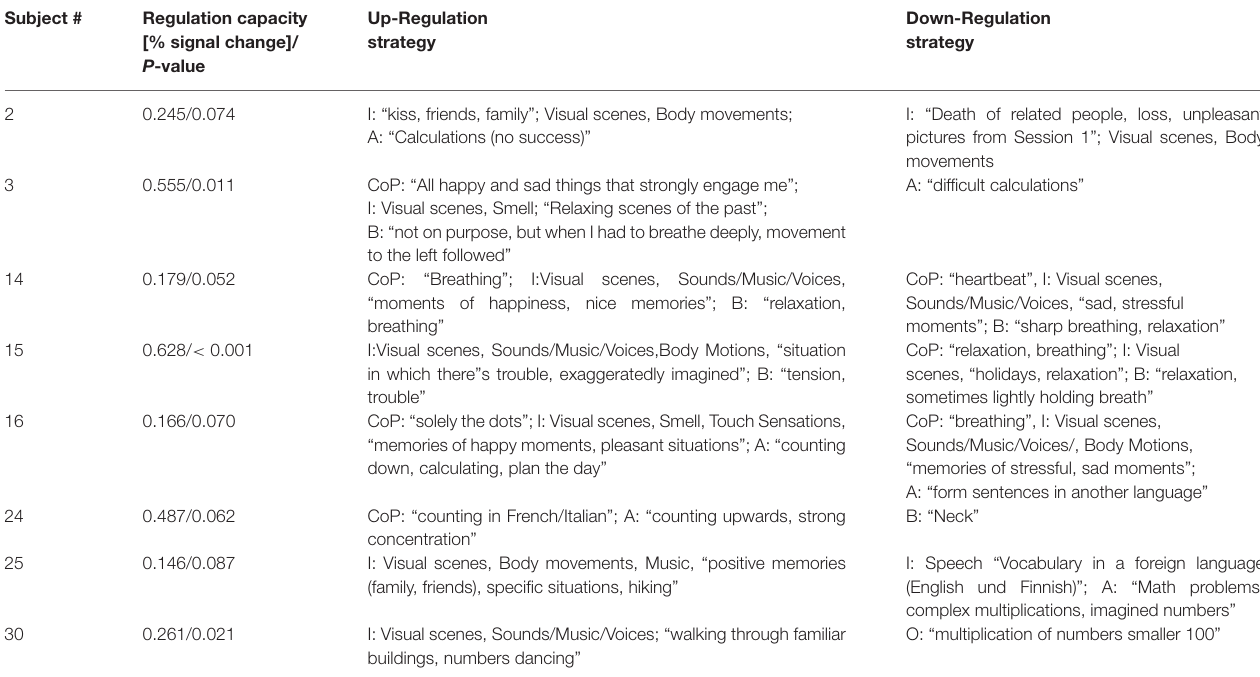
TABLE 1 | Summary of regulation strategies judged as most successful by the eight best regulators (highest subject-level median amygdala P -values for the contrast